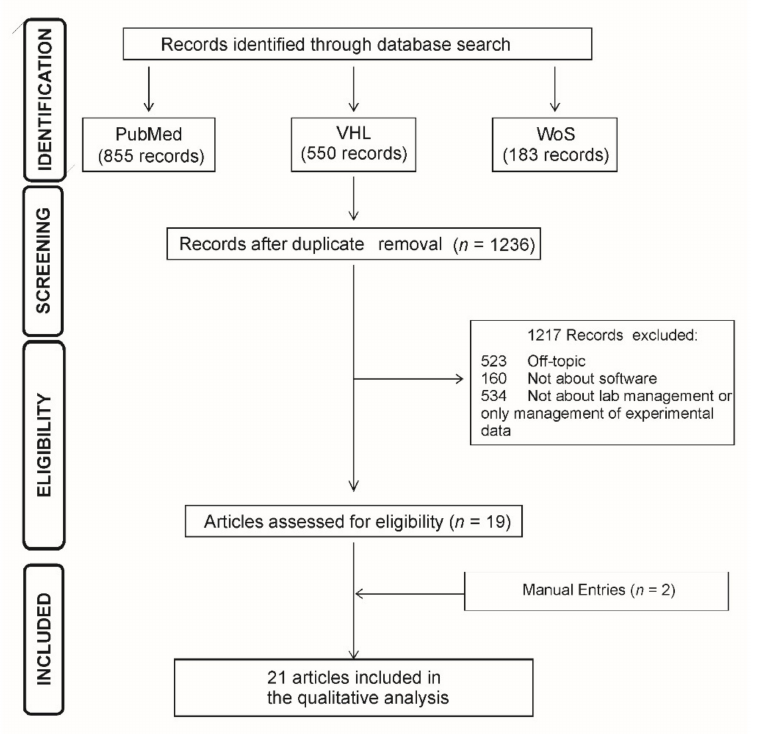
Figure 1. PRISMA flowchart of study screening and